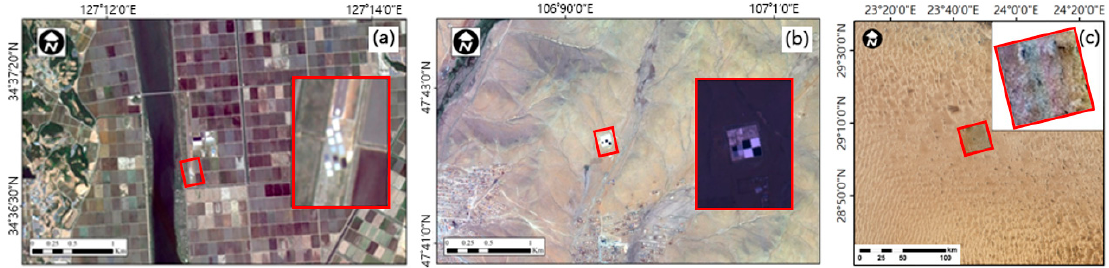
Figure 3. The field campaign site. ( a ) Goheung site on May 27, 2015; ( b ) Zuunmod site on June